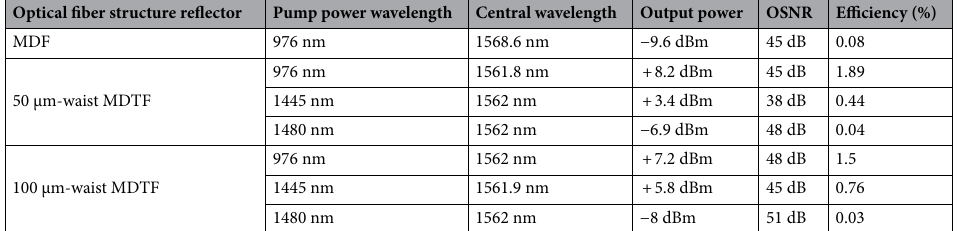
Optical fiber structure reflector